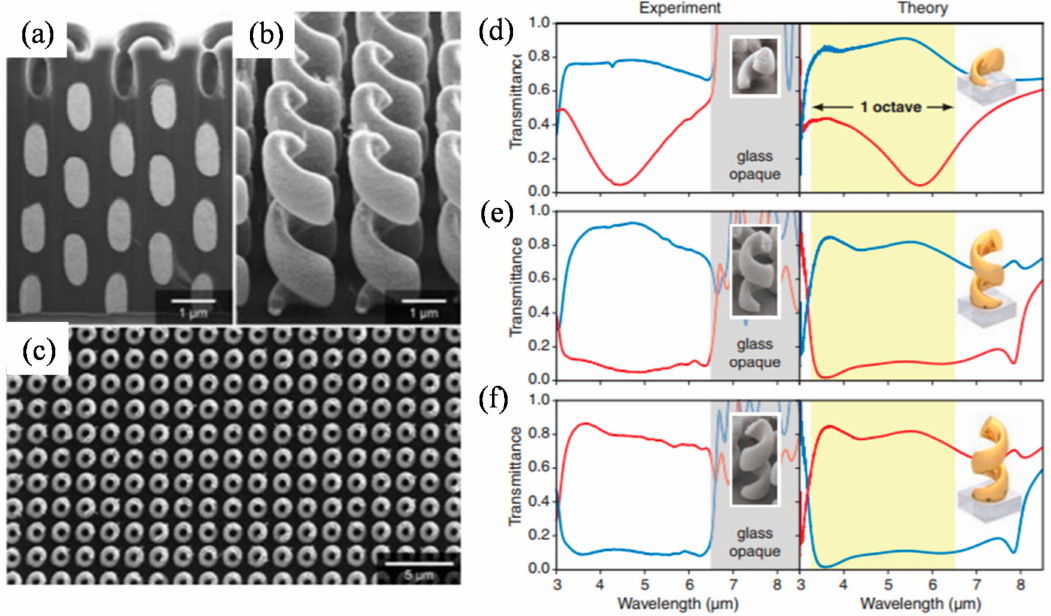
Figure 12. ( a – c ) SEM images of helix MM circular polarizer (HMCP) made by J. K. Gansel et al. [158]. Transmission spectra of HMCP with: ( d ) one; ( e ) two; and ( f ) three pitches of helices. Blue and red curves represent RCP and LCP, respectively. From Reference [158]. Reprinted with permission from